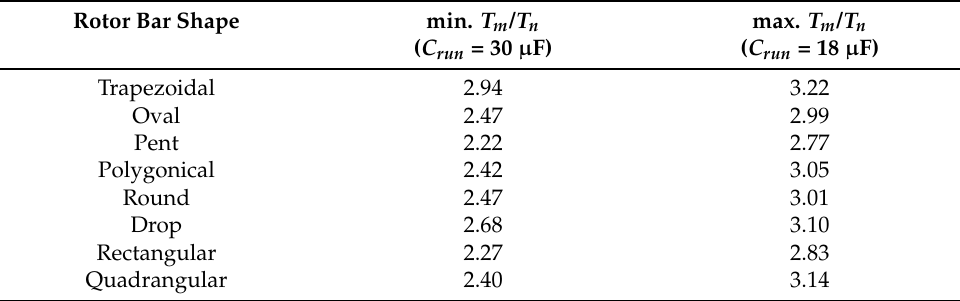
Table 11. Minimum and maximum T m / T n ratio values of the resulted